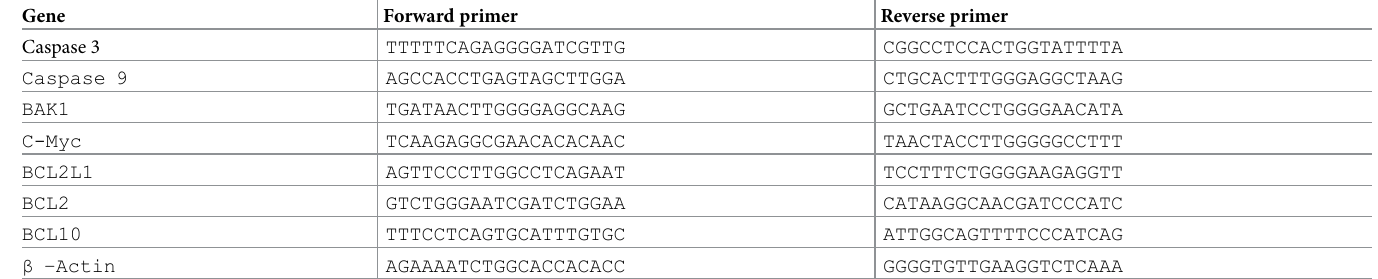
Table 1. Gene specific forward and reverse primer sequences for caspase-3, and -9, BAK1, c-Myc, BCL2L1, BCL2, BCL10, and housekeeping reference gene β -actin and